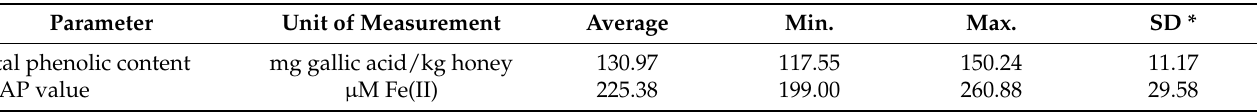
Table 2. Total phenolic content and antioxidant capacity of Himalayan balsam